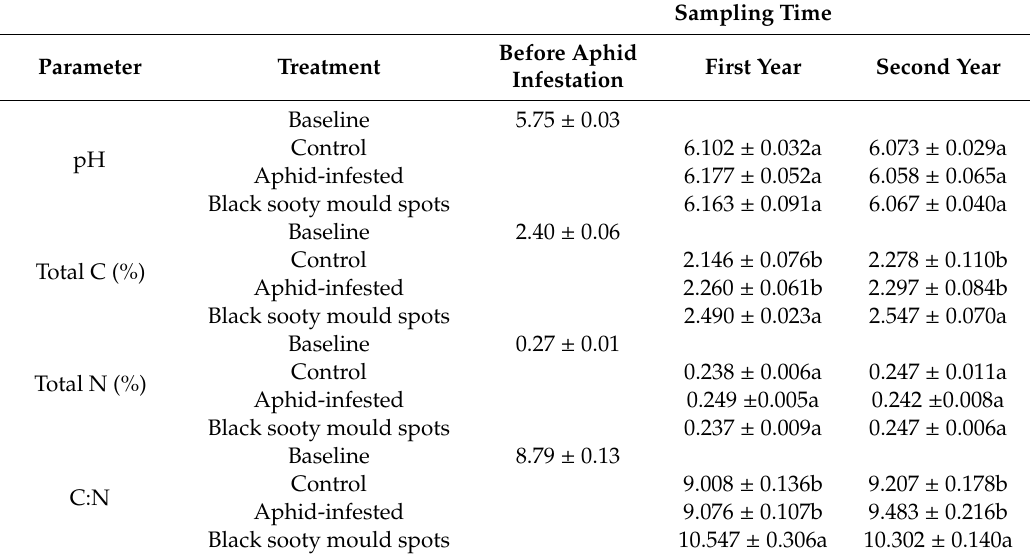
Table 1. Soil chemical properties before aphid inoculation (baseline) and after aphid inoculation (control, aphid-infested and black sooty mould spots), during the first and second year of the experiment. Values are the means ± SE. Di ff erent letters in each column indicate significant di ff erences between the treatments at each sampling time (Tukey’s HSD test, α =